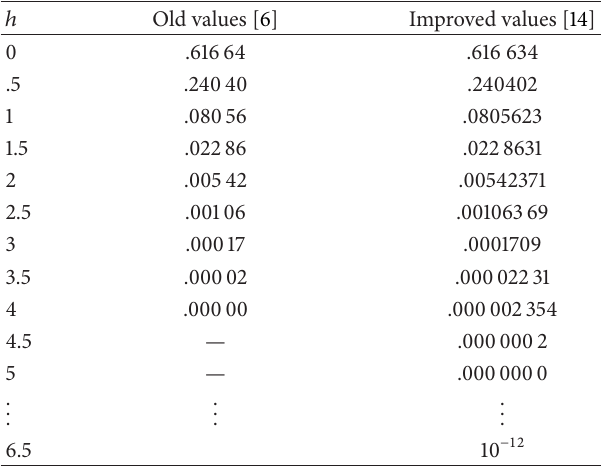
Table 1: Computed values of 𝐹 5/2 (ℎ) used to build the approxima- tion